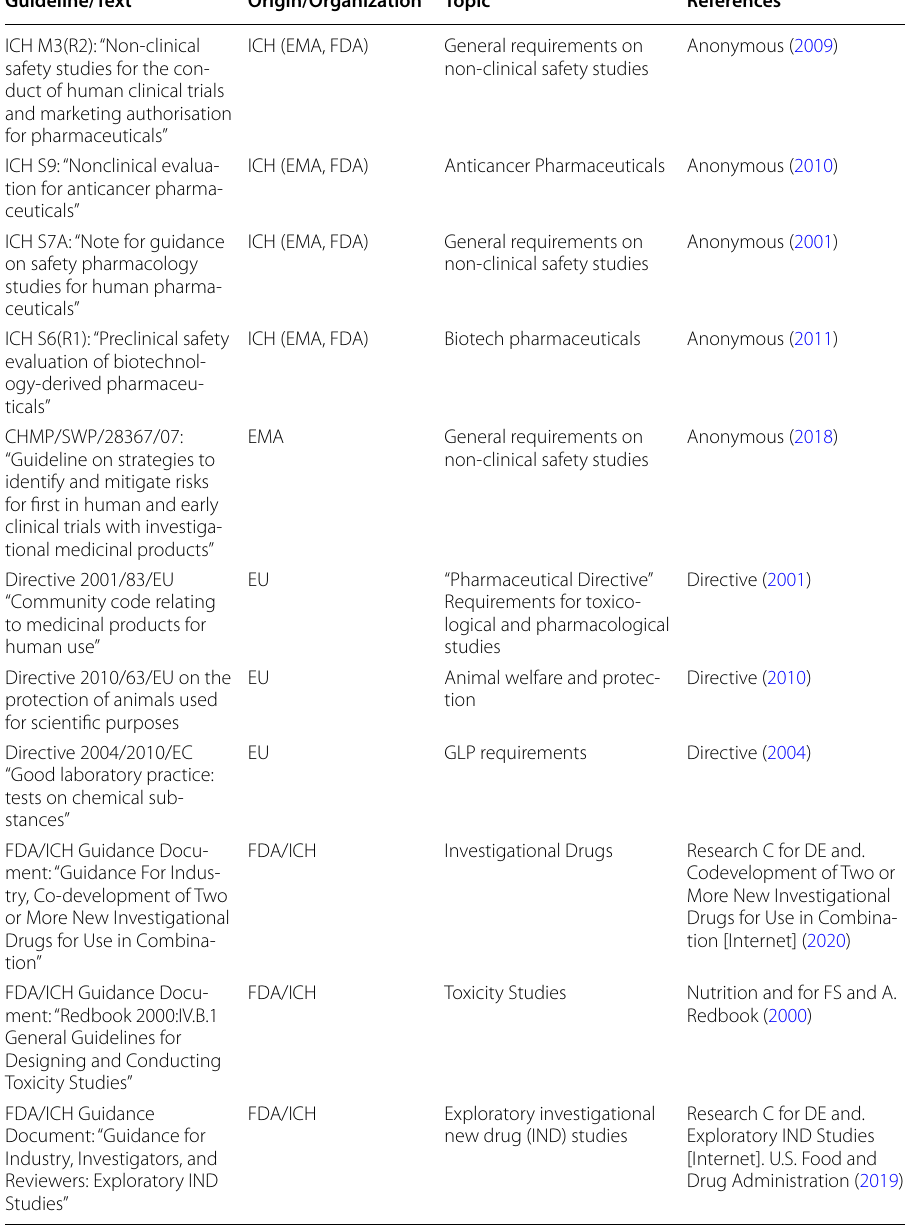
Table 1 Guideline documents from regulatory bodies on pharmaceuticals in general